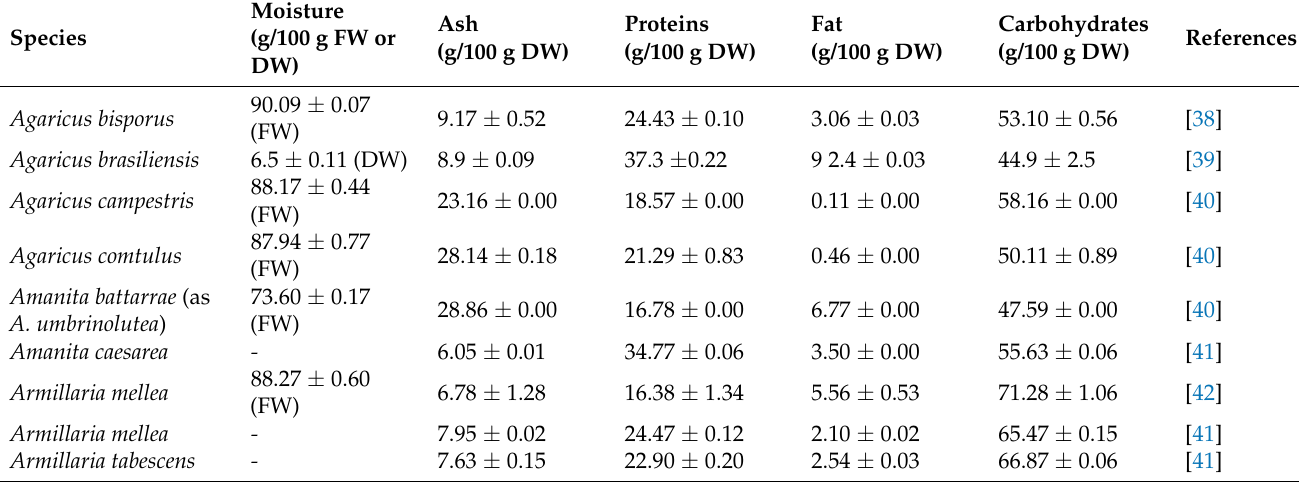
Table 1. Nutrient content of some economically important and other selected mushroom